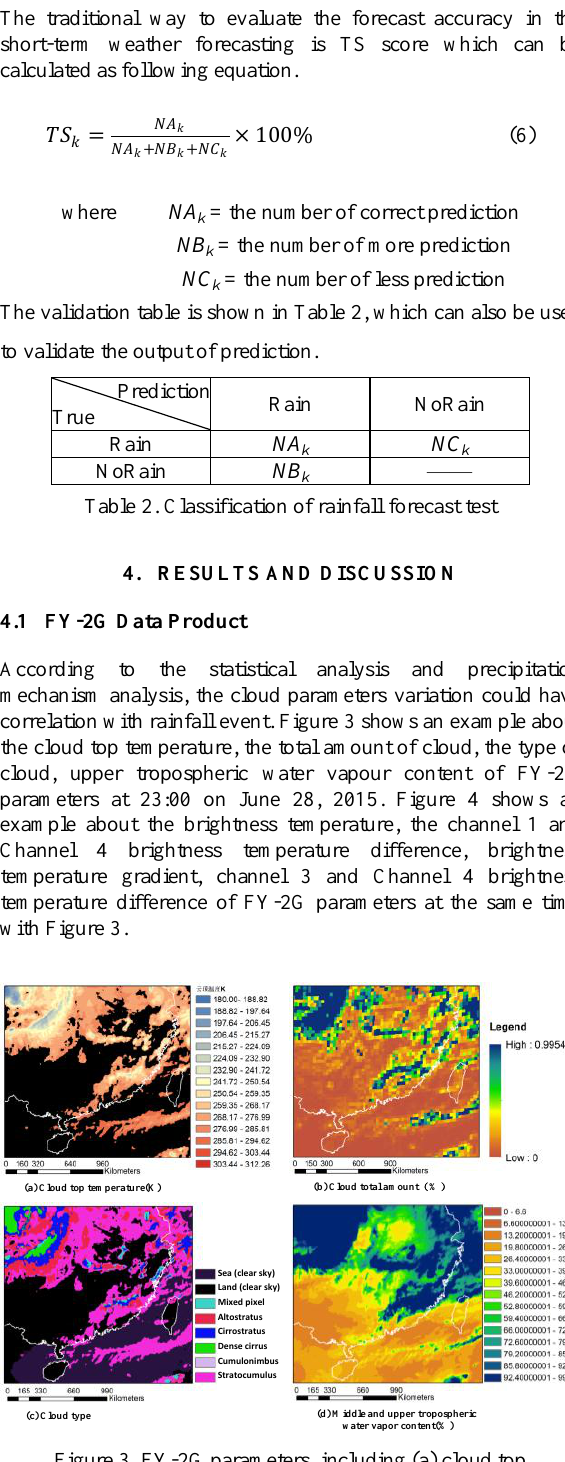
Figure 3. FY-2G parameters, including (a) cloud top temperature, (b) the total amount of cloud, (c) the type of cloud, (d) upper tropospheric water vapor